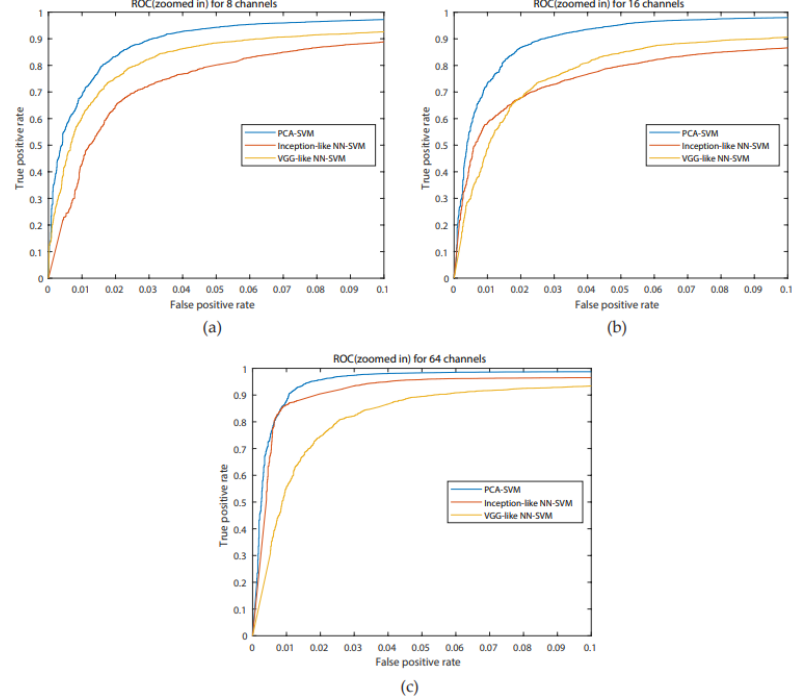
Figure 7. ROC curves for the PCA-SVM (blue), inception-like NN-SVM (red), VGG-like NN-SVM (yellow) for a false positive rate (FAR) ranging from 0 to 0.1 to emphasize differences for 8 channels ( a ), 16 channels ( b ), 64 channels ( c ).